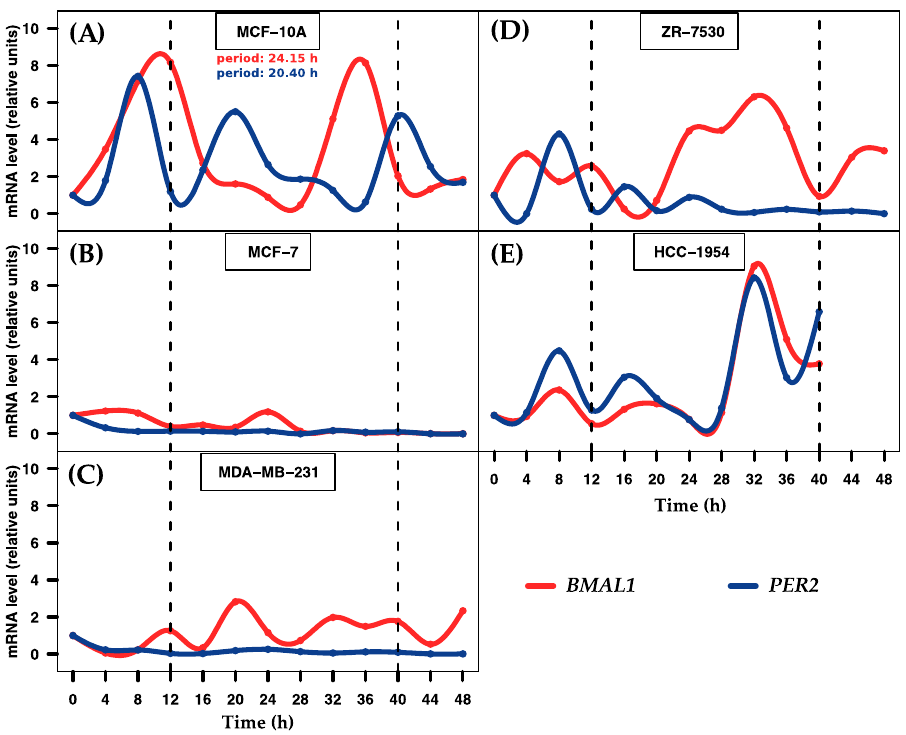
Figure 1. Temporal expression of BMAL1 and PER2 genes in five breast cell lines. The graph depicts the level of expression of two clock genes at 4 h intervals over 48 h after 2 h serum shock entrainment. ( A ) MCF-10A cells show rhythmic profiles of both genes; ( B – E ) MCF-7, MDA-MB-231, ZR-7530 and HCC-1954 cells do not show rhythmic profiles. Dashed black lines at 12 and 40 h were added to show the period during which the profiles exhibited robustness. Data points (means of two biological replicates) were normalized using GAPDH relative to the first time point ( t = 0) within each corresponding cell line.